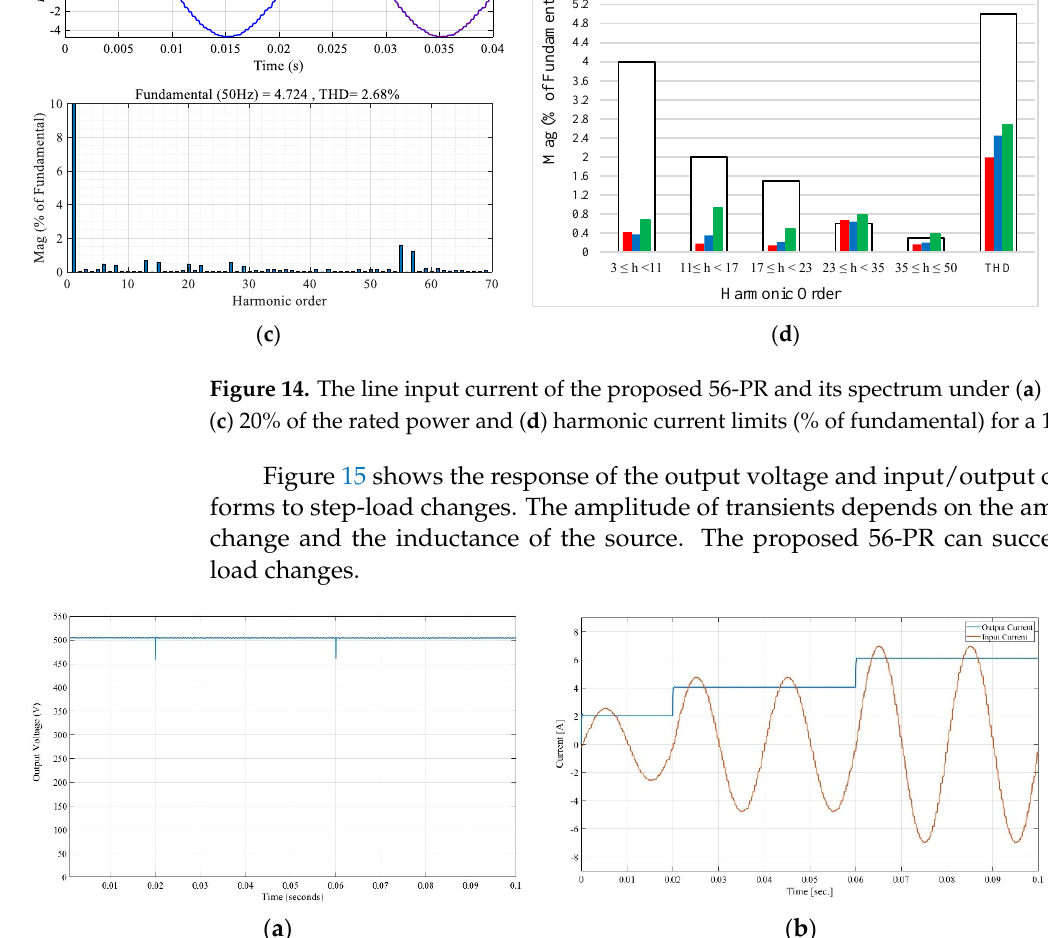
Figure 15. The response of the ( a ) output voltage and ( b ) input/output current to step-load chang- es.